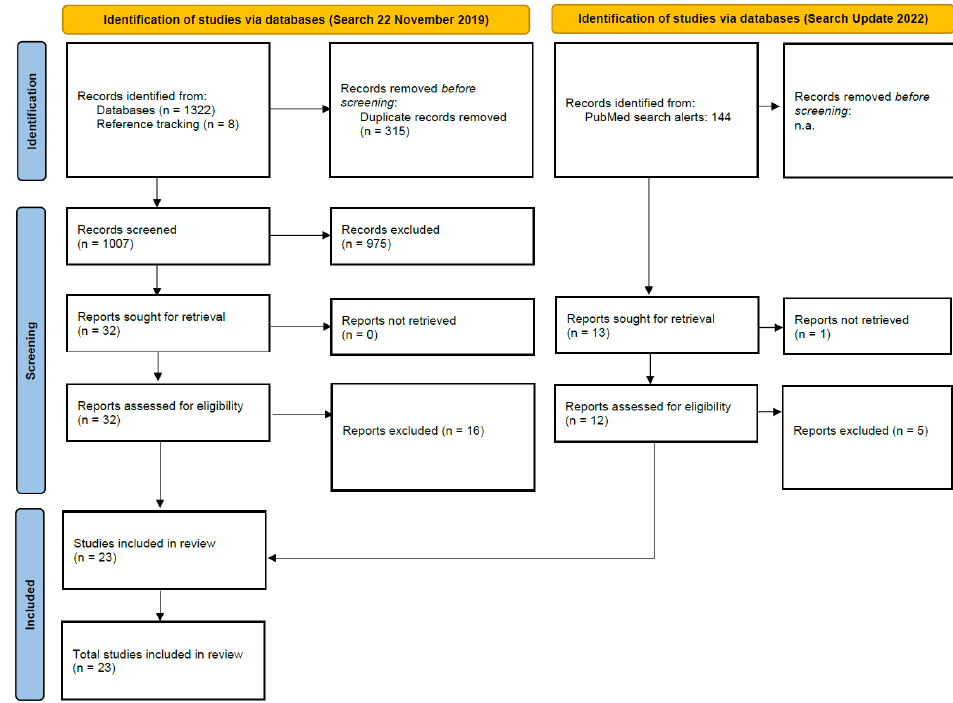
Figure 2. Result of review process based on (modified) PRISMA flow chart [24].